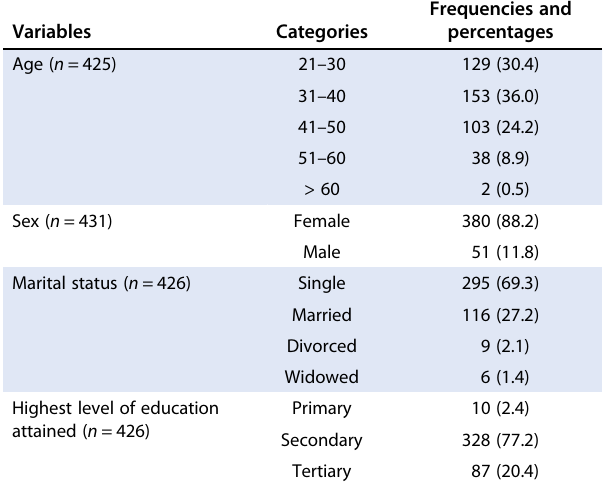
Table 1: CHWs ’ baseline characteristics